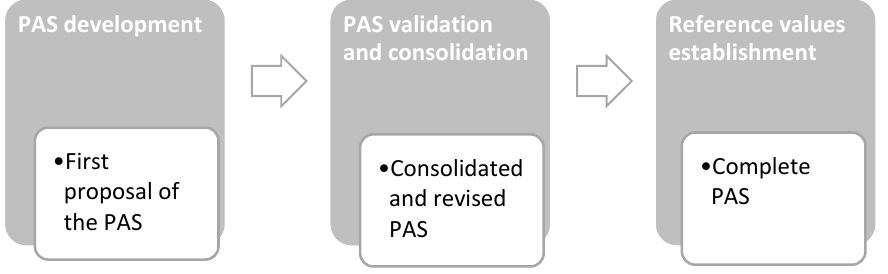
Figure 2. Stages for the construction of the PAS and main results.